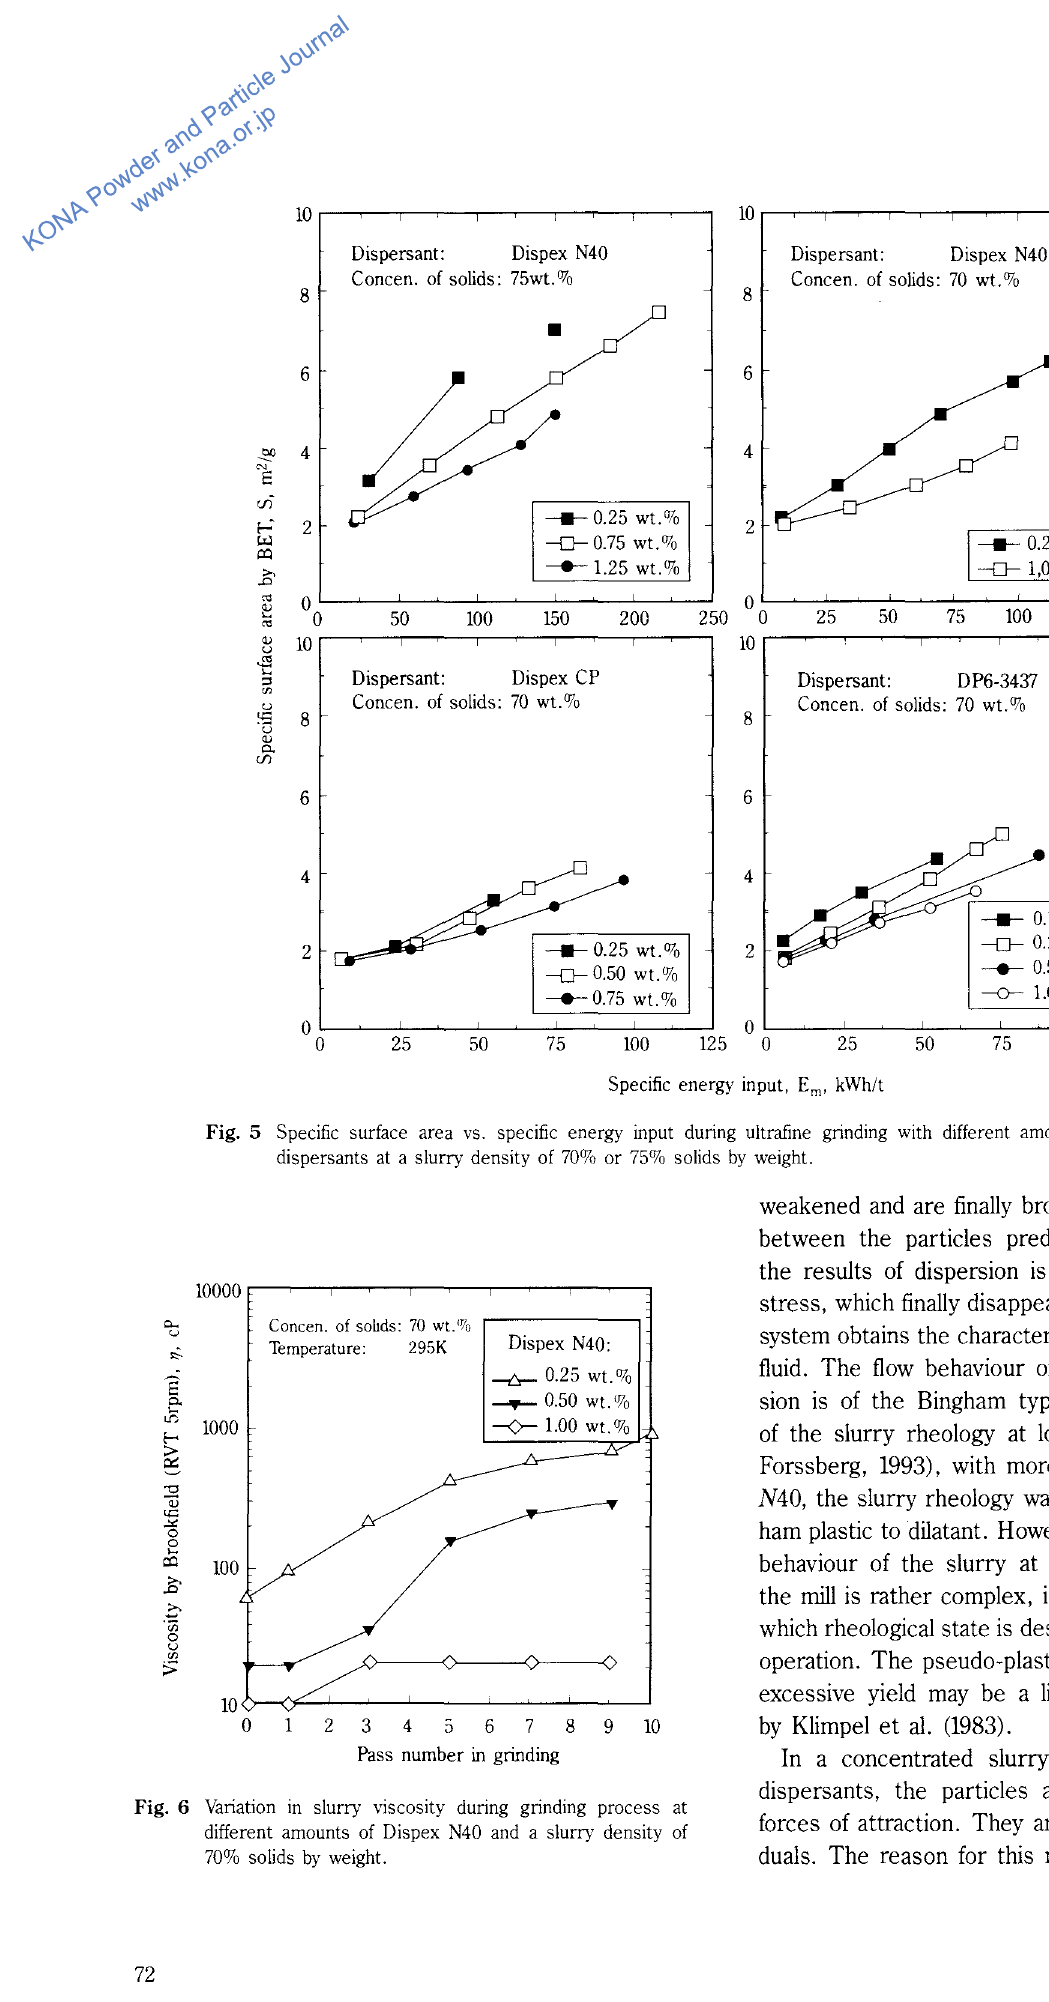
Fig. 6 Variation in slurry viscosity during grinding process at different amounts of Dispex N40 and a slurry density of 70% solids by